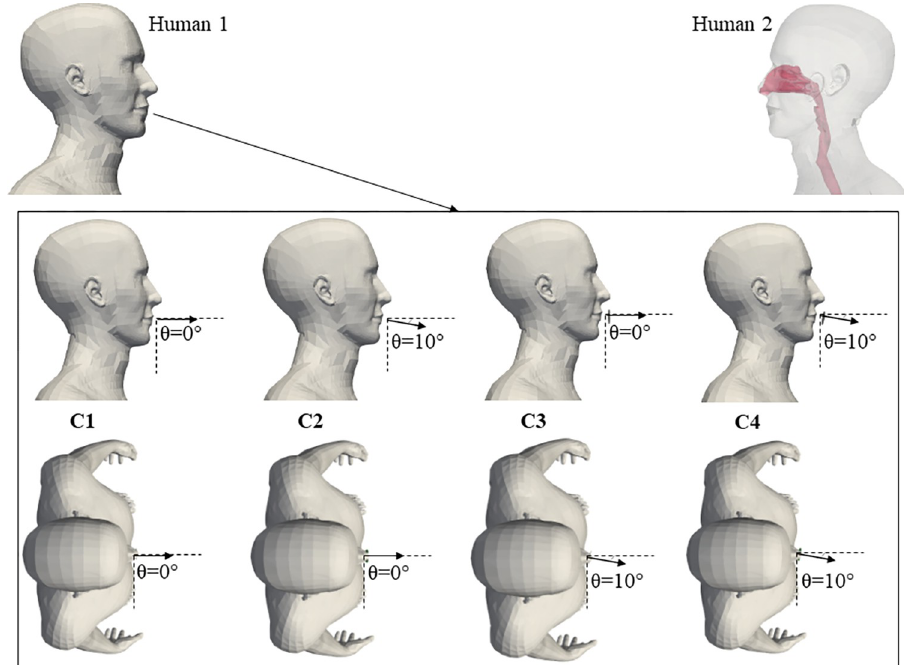
Fig 4. Angle variations of mouth for cases C1 to